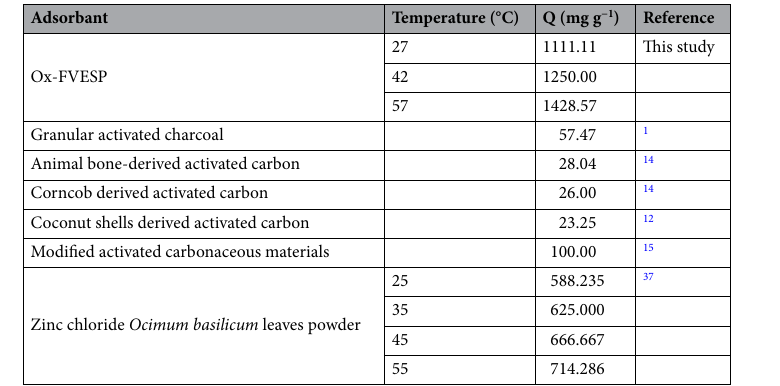
Table 6. Adsorption capacities for KMnO 4 removal by several